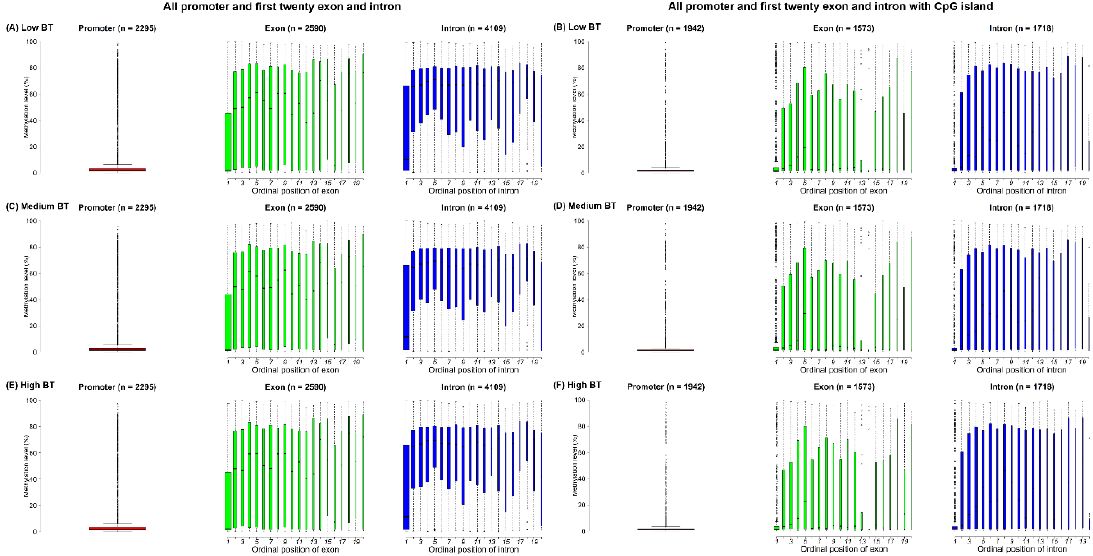
Figure 2. Boxplots of methylation levels (%) of promoters, the first twenty ordinal positions of exons and introns for the ( A and B ) low, ( C and D ) medium and ( E and F ) high BT groups. Note: The widths of boxplots indicate the proportion to the square-root of the number of observations. The number within brackets indicate the number of promoters, exons and introns used in the figure visualization.